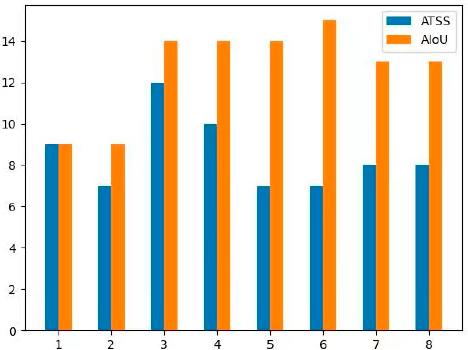
Figure 10. Illustration of the number of positive samples allocated by the ATSS and the AIoU. The horizontal axis represents the aspect ratio. The vertical axis represents the number of positive sam- ples.